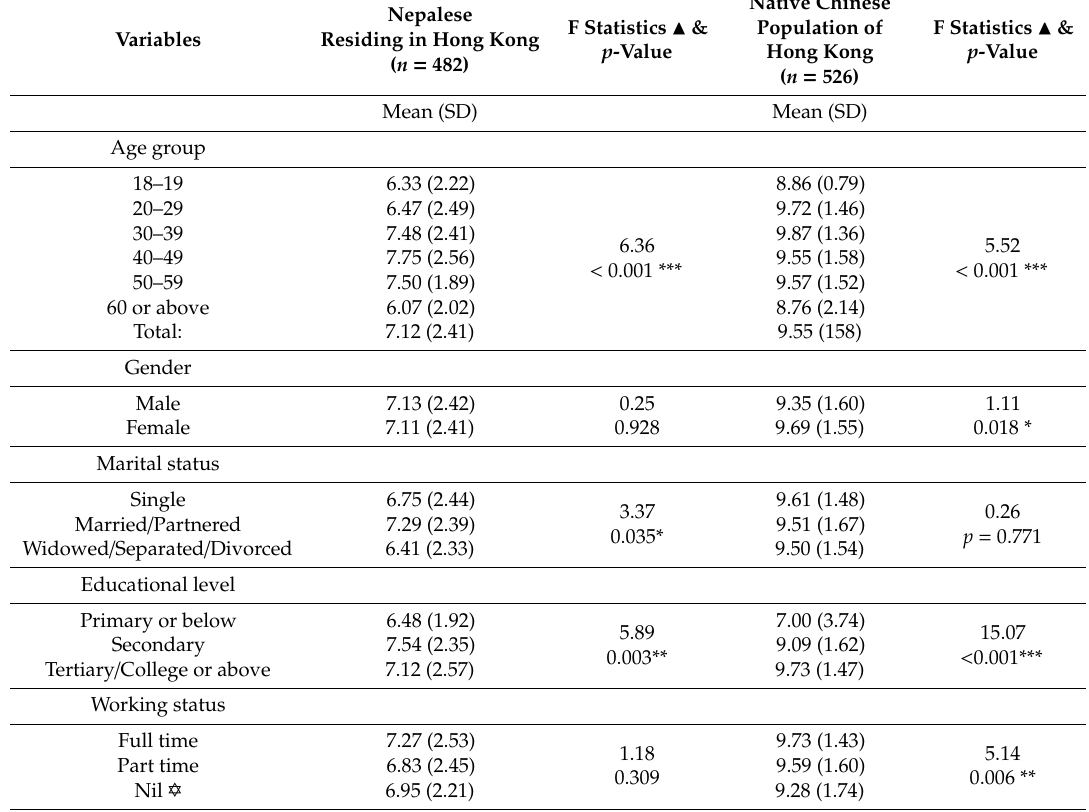
Table 3. Association between knowledge level on hand hygiene (0 to 12) and characteristics of